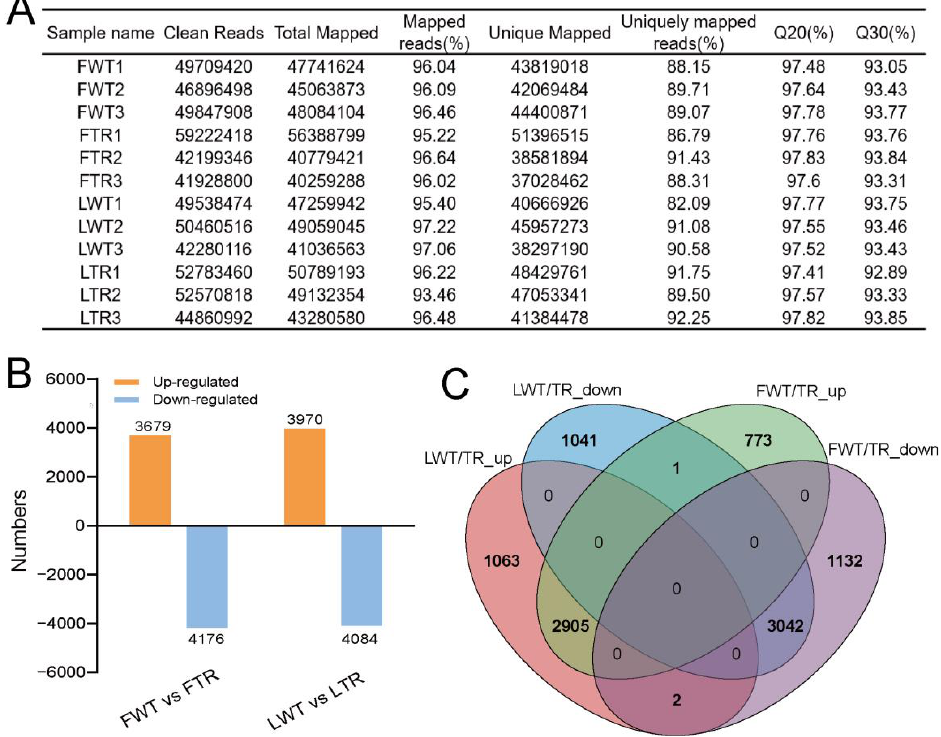
Figure 4. Statistical summary of flax transcriptomes. ( A ) Digest of data generated in flax transcrip- tome sequencing. ( B ) The number of upregulated (orange) and downregulated (blue) DEGs be- tween each comparison. ( C ) Venn diagram showing the number of shared upregulated and down- regulated DEGs among the two varieties. FWT, water treatment Fanni; FTR, NaCl stress-treated Fanni; LWT, water treatment Longya10; LTR, NaCl stress-treated Longya10.